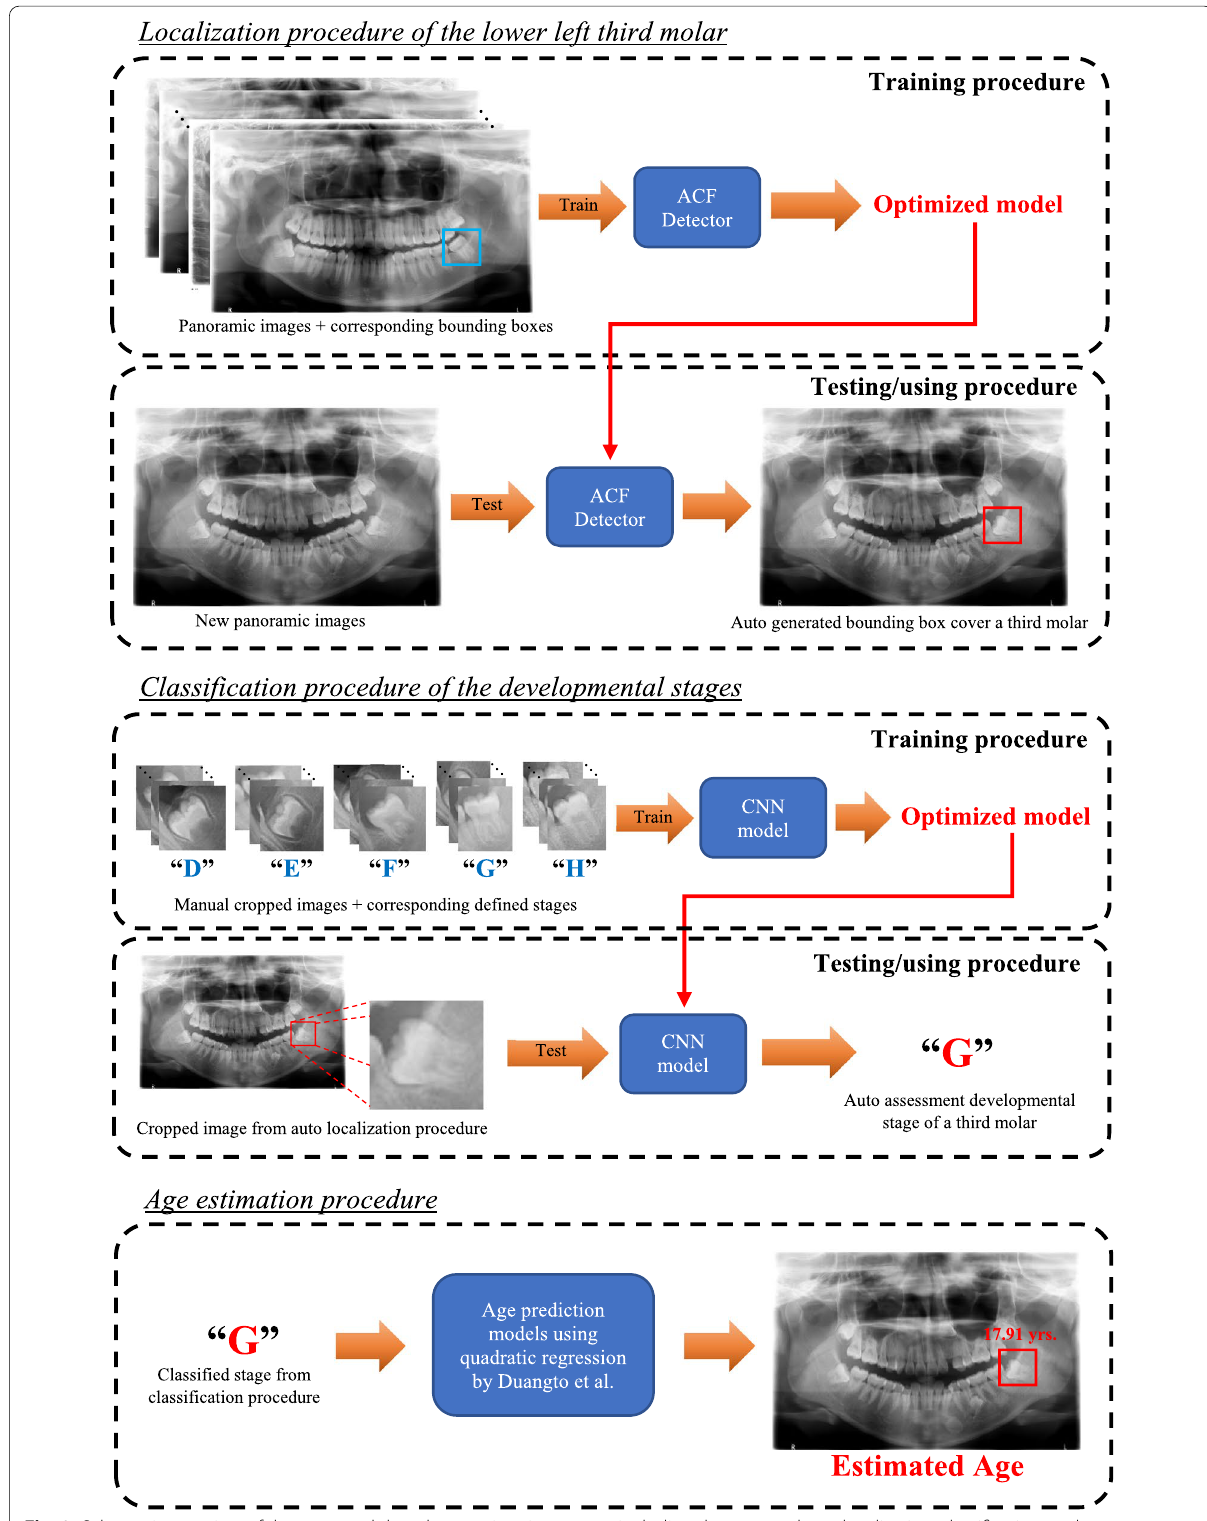
Fig. 2 Schematic overview of the proposed dental age estimation system including three procedures: localization, classification, and age